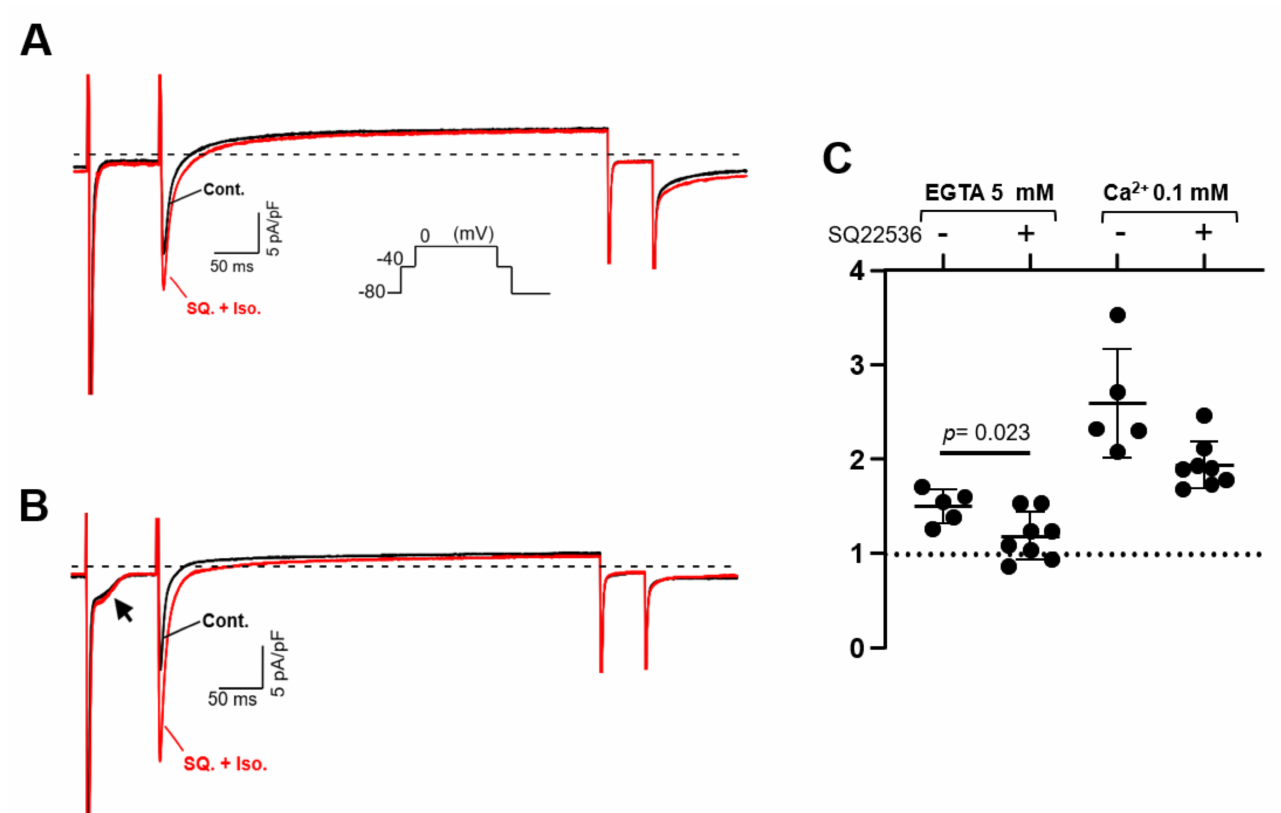
Figure 7. Effect of SQ22536 (SQ) on L-type Ca 2+ current in pulmonary vein (PV) cardiomyocytes. The response of the Ca 2+ current was recorded after 5 µ M SQ application for approximately 2 min. The pulse protocol is inserted in ( A ). Intracellular Ca 2+ is chelated by 5 mM EGTA in ( A ), while the internal solution contains 0.1 mM Ca 2+ in ( B ). Dashed lines indicate zero current level. The rate